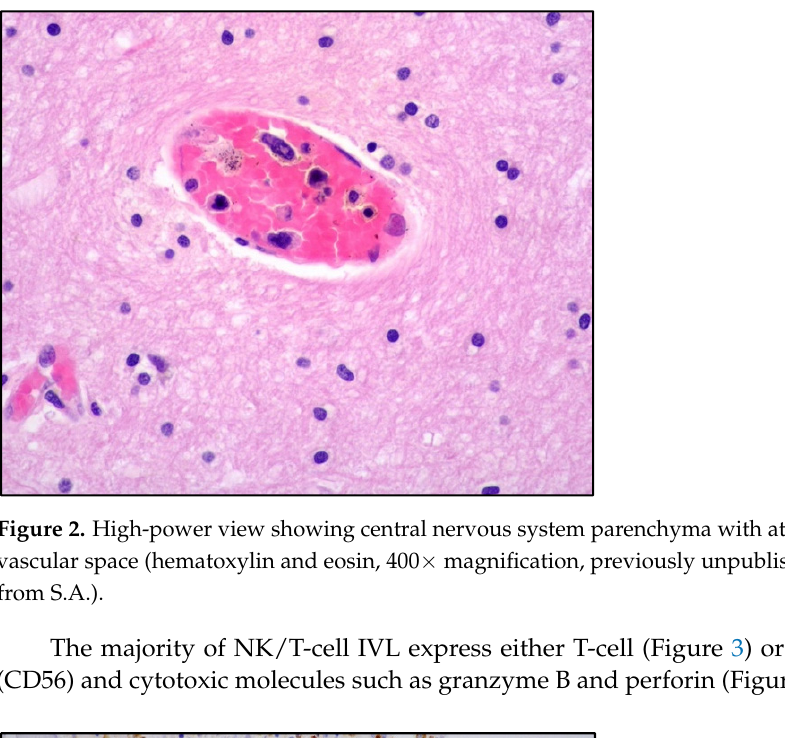
Figure 4. High-power view showing lung parenchyma with perforin-positive atypical cells within vascular spaces (perforin immunostaining, 200× magnification, previously unpublished, original image from S.A.).